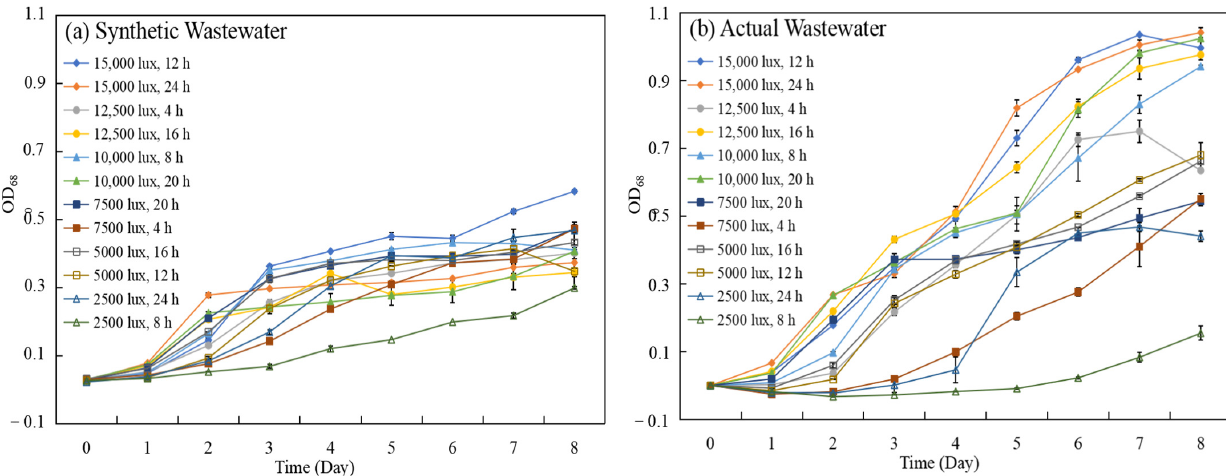
Figure 5. The uniform design results of the effect under different light intensity and daily light time on the growth of Scenedesmus dimorphus in ( a ) Synthetic wastewater, ( b ) Actual wastewater. ( n = 3).